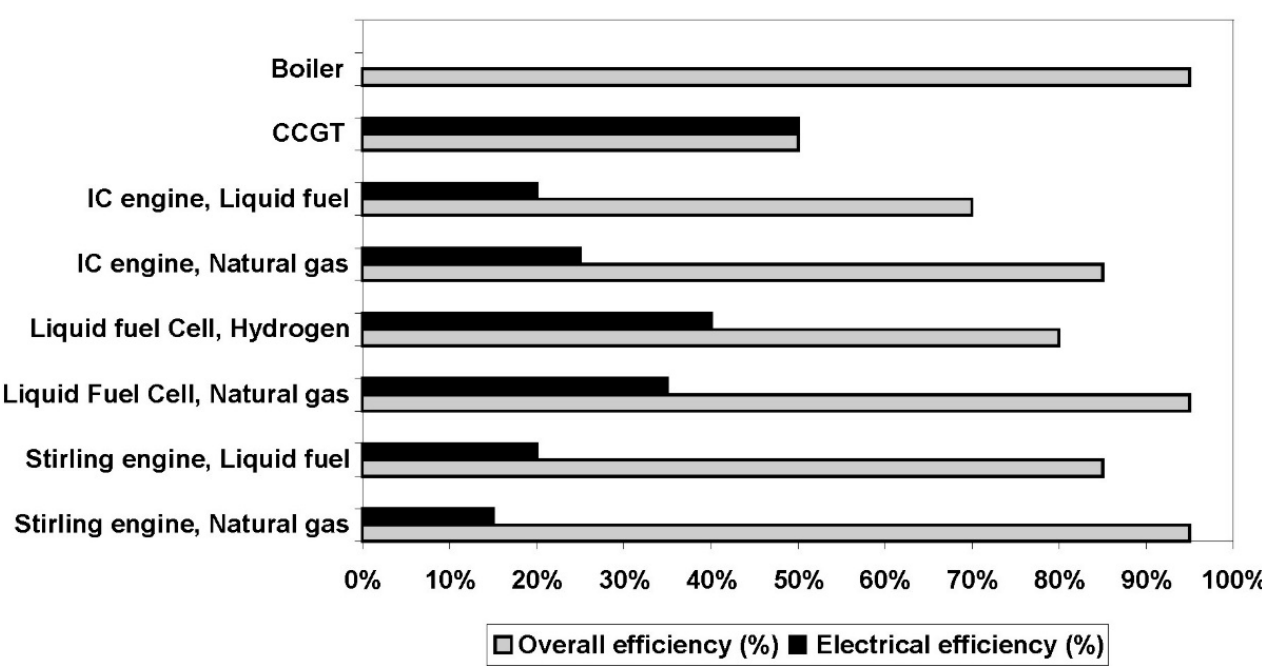
Figure 11. Overall and electrical efficiency for conventional and micro-CHP systems. Source: Re- printed with permission from Ref. [18]. 2011, University of Nis—Faculty of Mechanical Engineering.